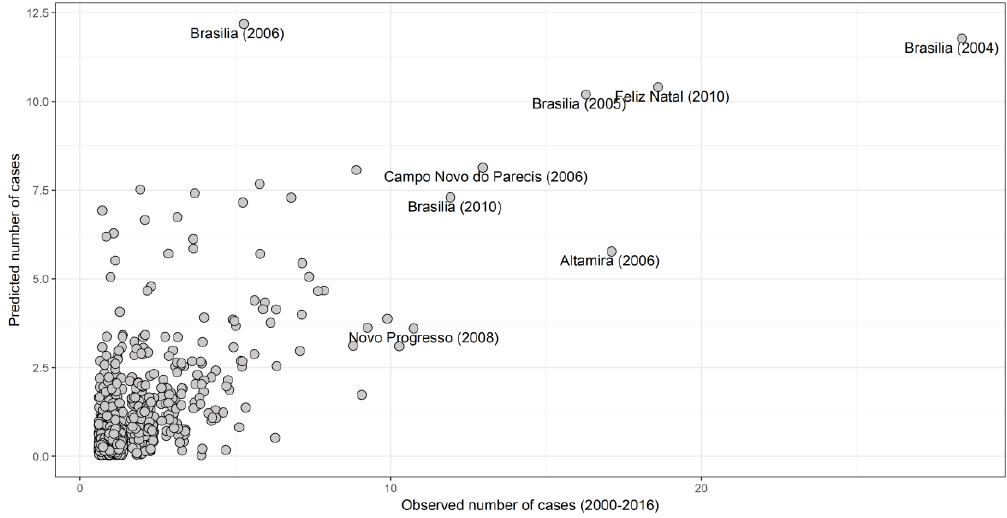
Figure 4. Scatterplot with the number of HCPS cases observed and predicted by a zero truncated Poisson model. Each point represents the number of hantavirus disease notified cases in a municipality in one year.